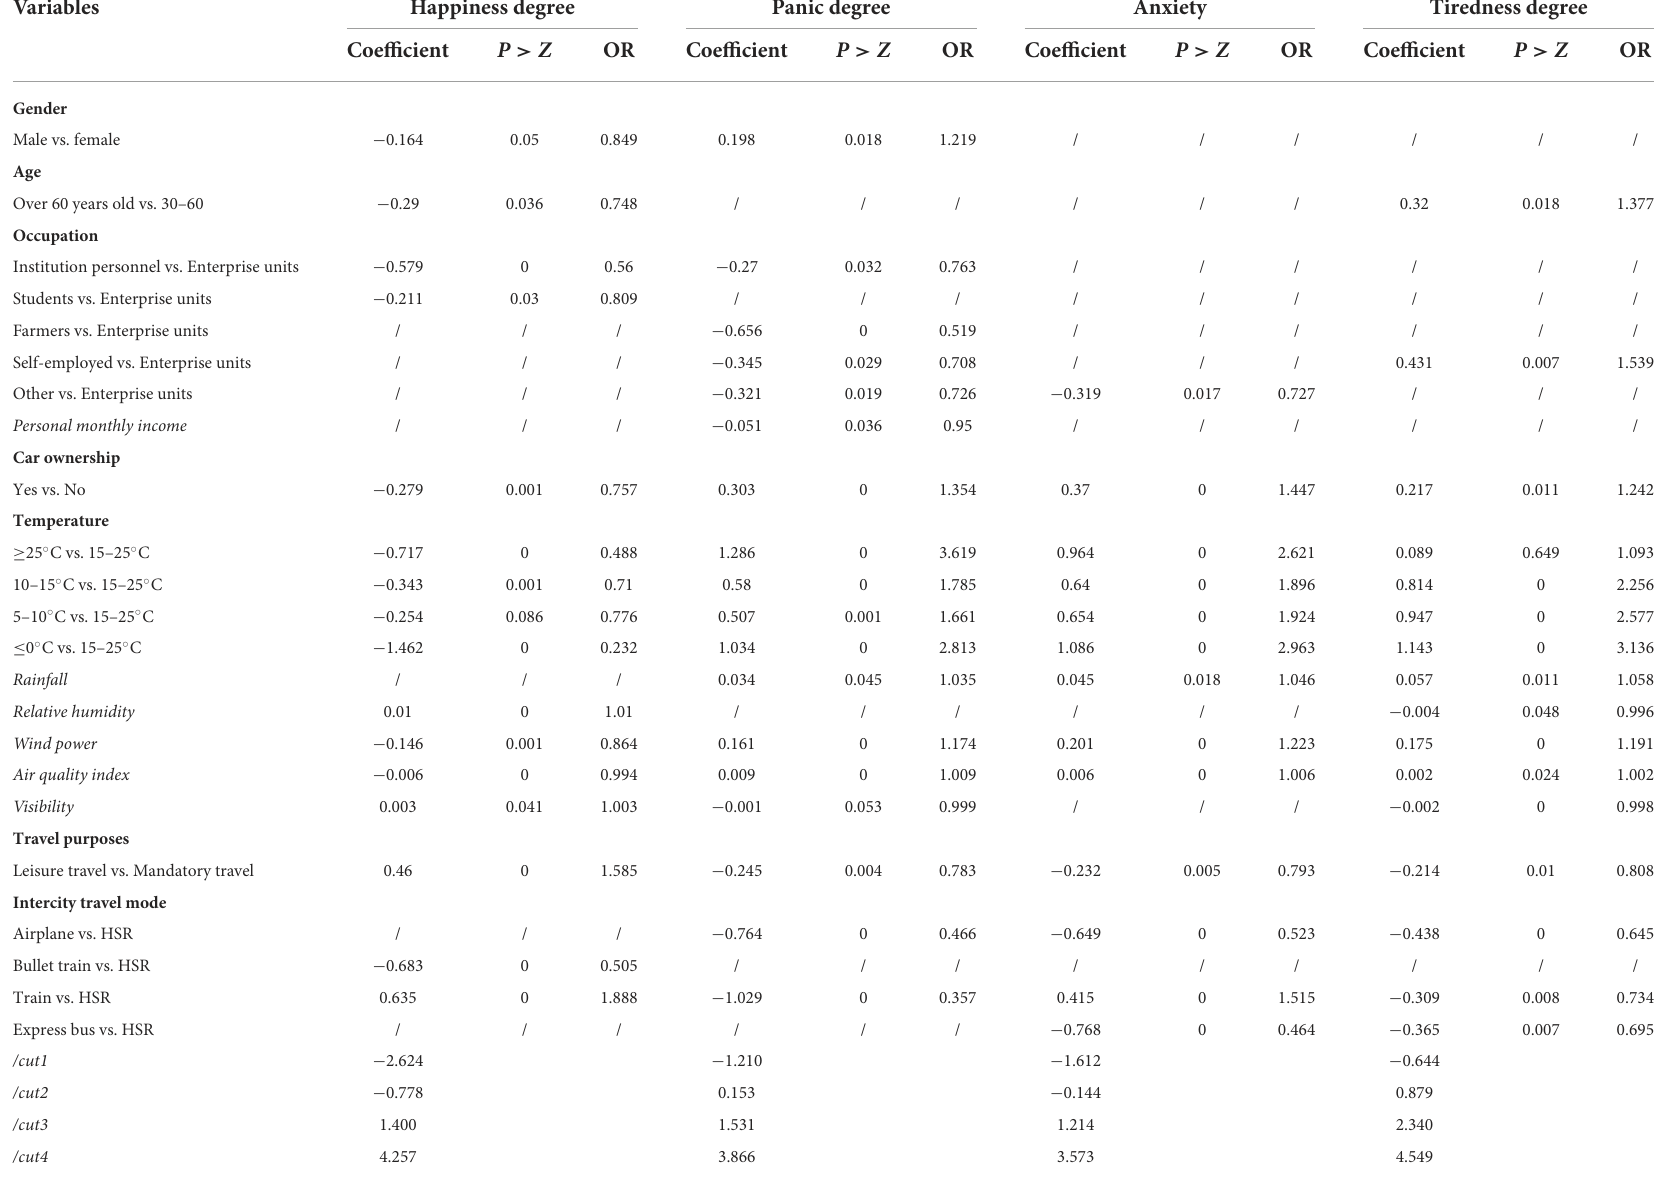
TABLE 8 Parameter estimation from OLM. Variables